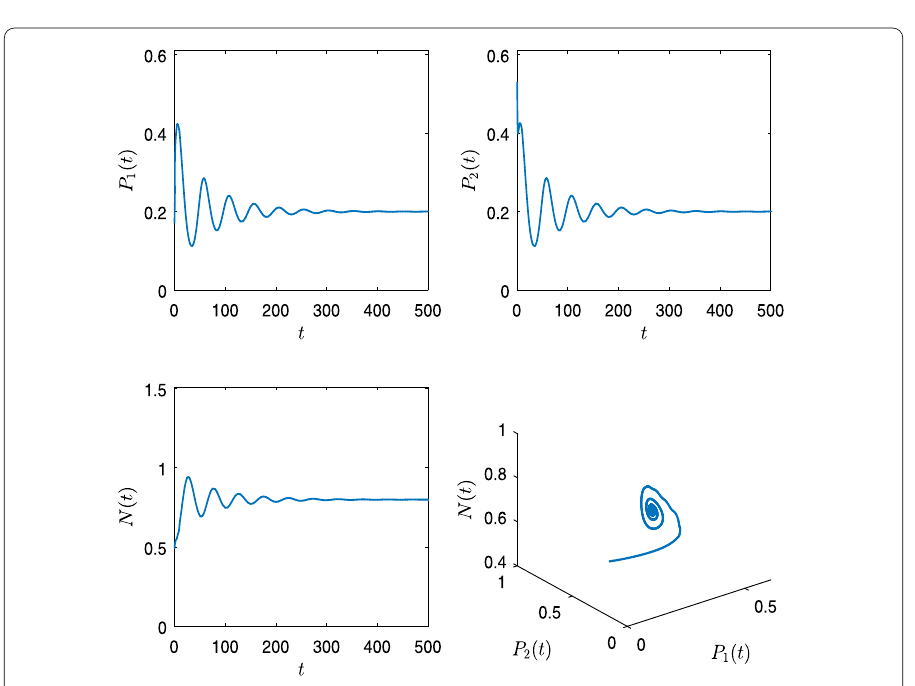
Figure 5 E † of system (35) is stable when τ = 8, k = –0.7, σ = 4